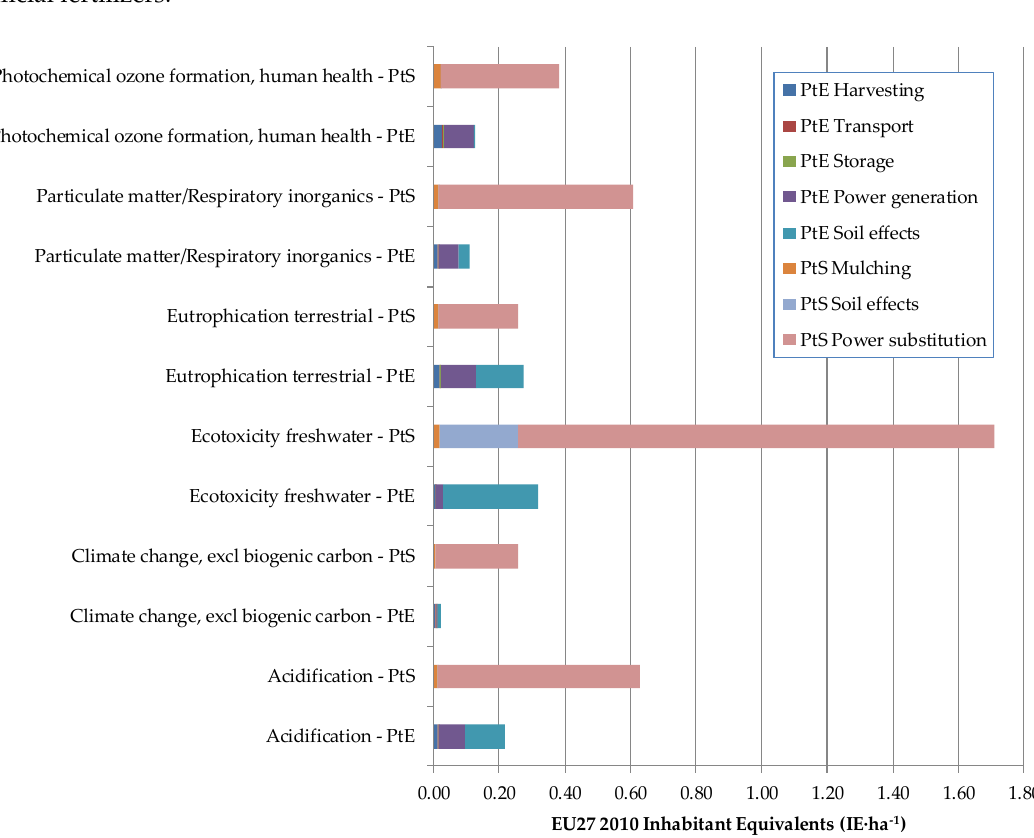
Figure 5. Environmental impacts of pruning residues in Spanish peach orchards (pruning residues before harvest: 2.59 tFM·ha − 1 ). before harvest: 2.59 tFM · ha − 1